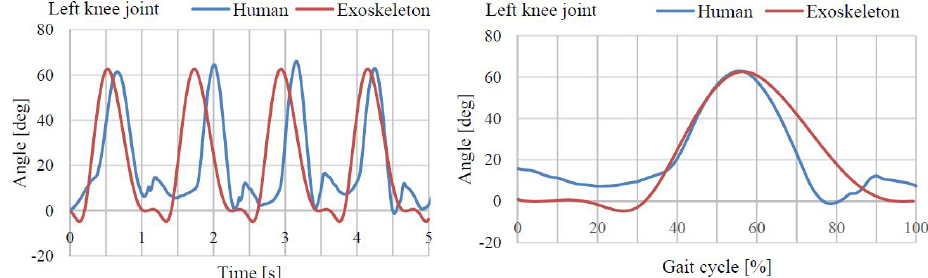
Figure 25. Compared variation of knee joint angle for human subject and for exoskeleton model.